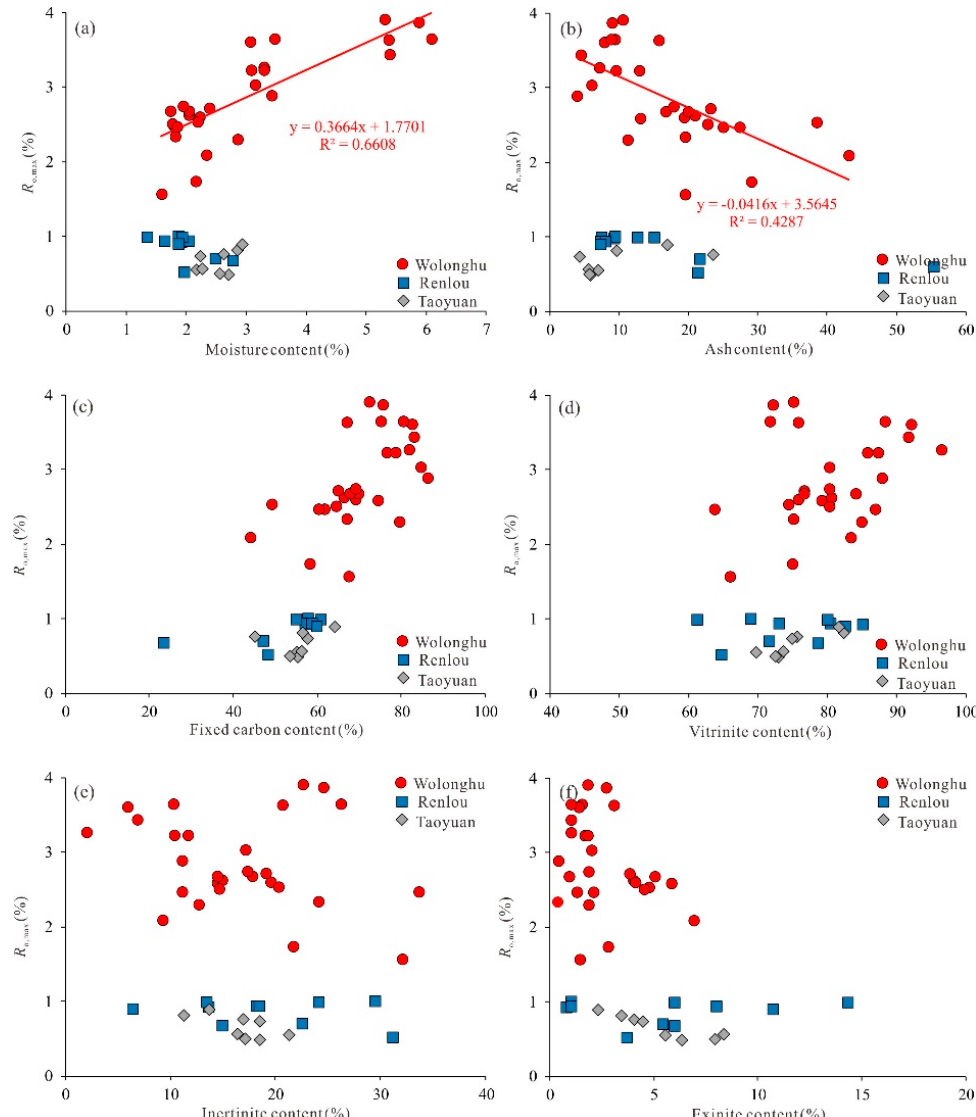
Figure 9. Correlations among chemical compositions ( a – c ), maceral components ( d , e ) and R max ( f ) of the selected samples in the Huaibei Coalfield.